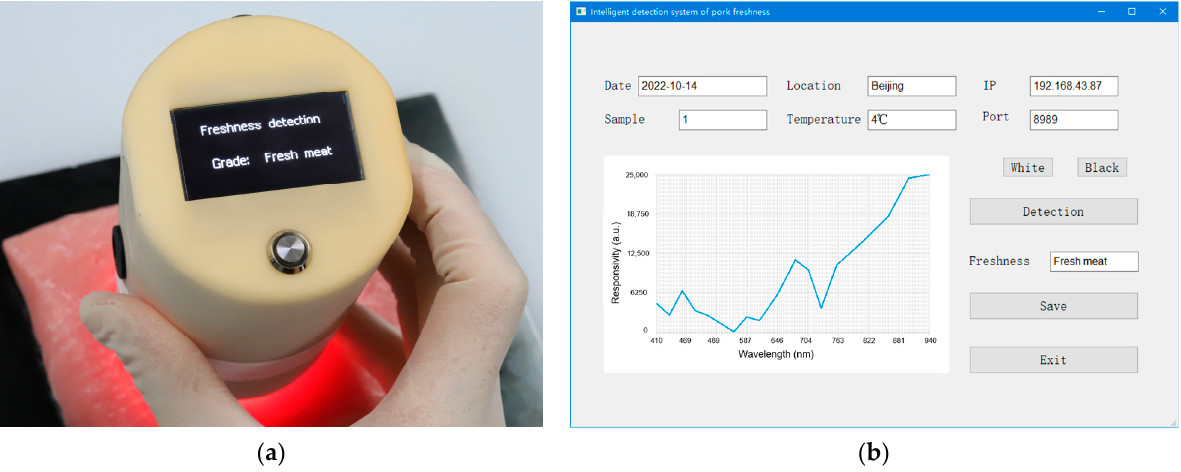
Figure 2. ( a ) Pork freshness detector prototype; ( b ) Pork freshness detector remote control